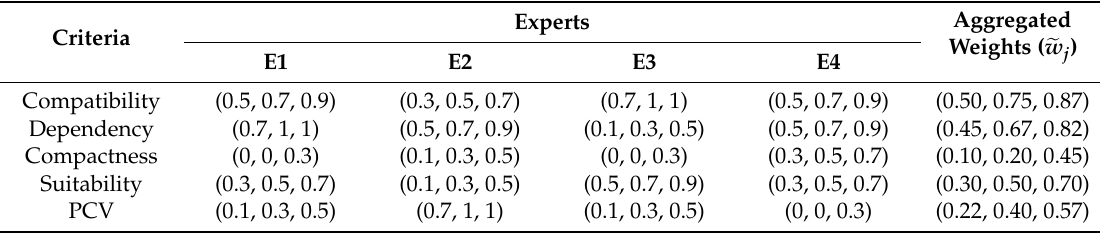
Table 6. Aggregated fuzzy weights of the